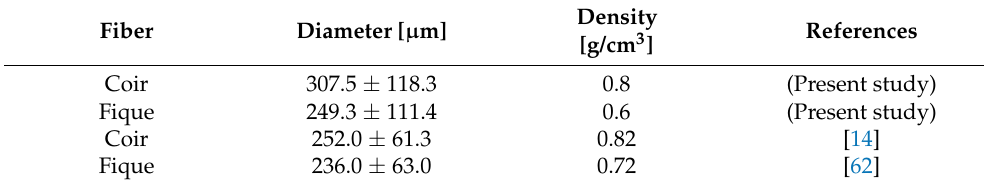
Table 3. Physical parameters for coir and fique fiber. Present work compared with previous reports.